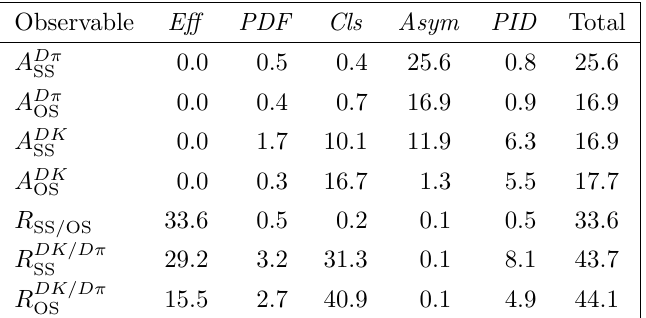
Table 2 . Systematic uncertainties for the K (cid:3) + region (cid:12)t. Uncertainties are quoted as a percentage of the statistical uncertainty for a given observable, and the total uncertainty is given by the sum in quadrature of each